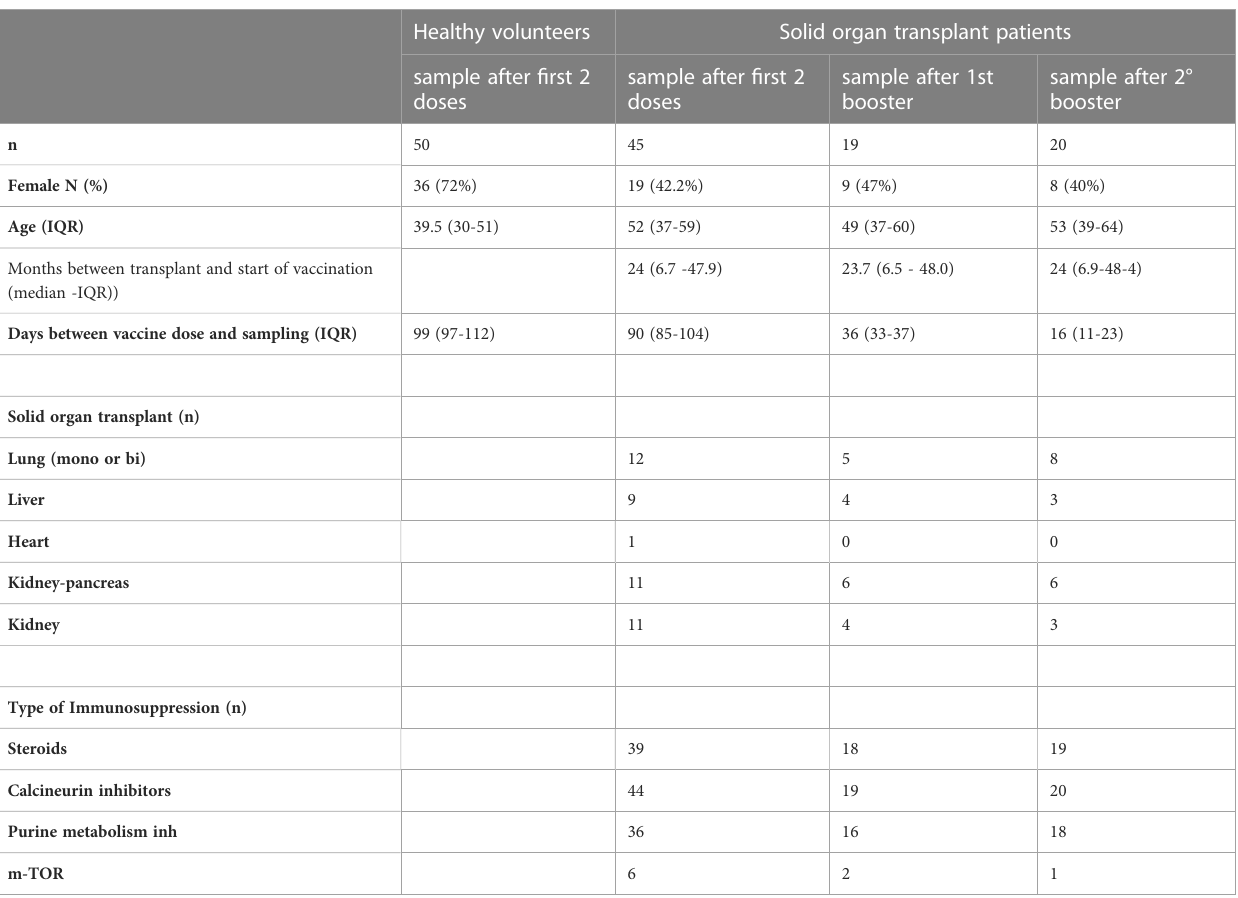
TABLE 1 Characteristics of study